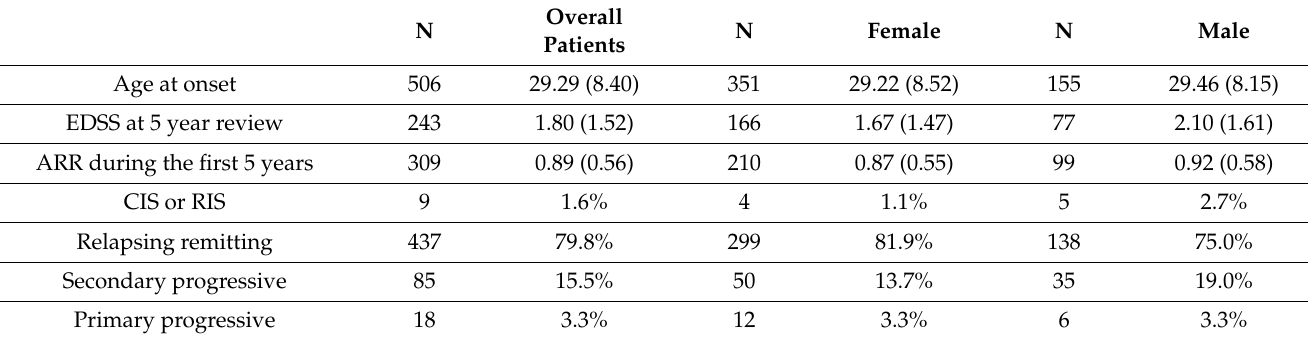
Table 1. Clinical characteristics of the recruited patients. For age at onset, Extended Disability Status Scale (EDSS), and annual relapse rate (ARR), the mean and standard deviation (in parenthesis) are presented. Only patients with available data in each category are included. Age at onset is measured in years. EDSS is a disability scale from 0 to 10, with 0 being no disability. ARR is the number of relapses corrected by a given time period (5 years after onset). The percentage of the different clinical forms is also presented in rows 4–7. Mean and standard deviation are presented for age at onset, EDSS, and ARR; percentage over the total population with confirmed clinical form is presented for CIS (clinically isolated syndrome), RIS (radiologically isolated syndrome), relapsing–remitting, secondary progressive, and primary progressive forms. All characteristics are calculated for the total sample, and for female and male